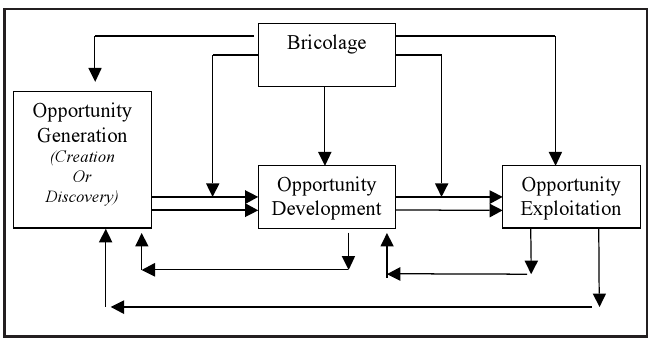
Figure 3. The Potential Effect of Bricolage on the Entrepreneurial